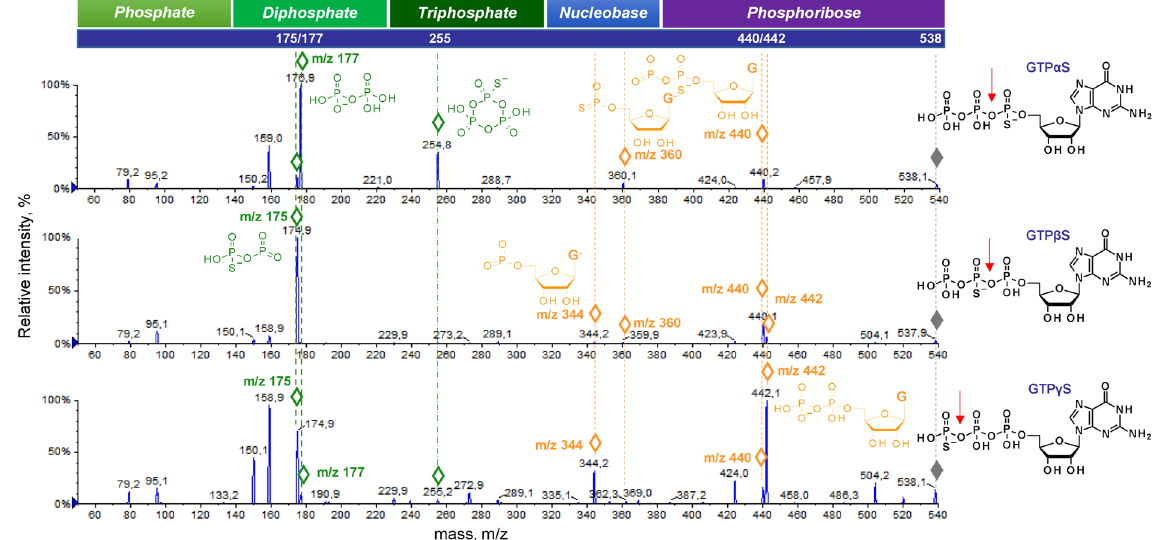
Figure 6. ESI( − )/MS/MS spectra of three GTPS isomers. In each spectrum, fragmentation ions crucial for the determination of the O-to-S substitution site (P α versus P β versus P γ ) are indicated with diamonds ( ◊ ) and their proposed structures are depicted. Red arrow above each compound indicates pyrophosphate bond most susceptible to